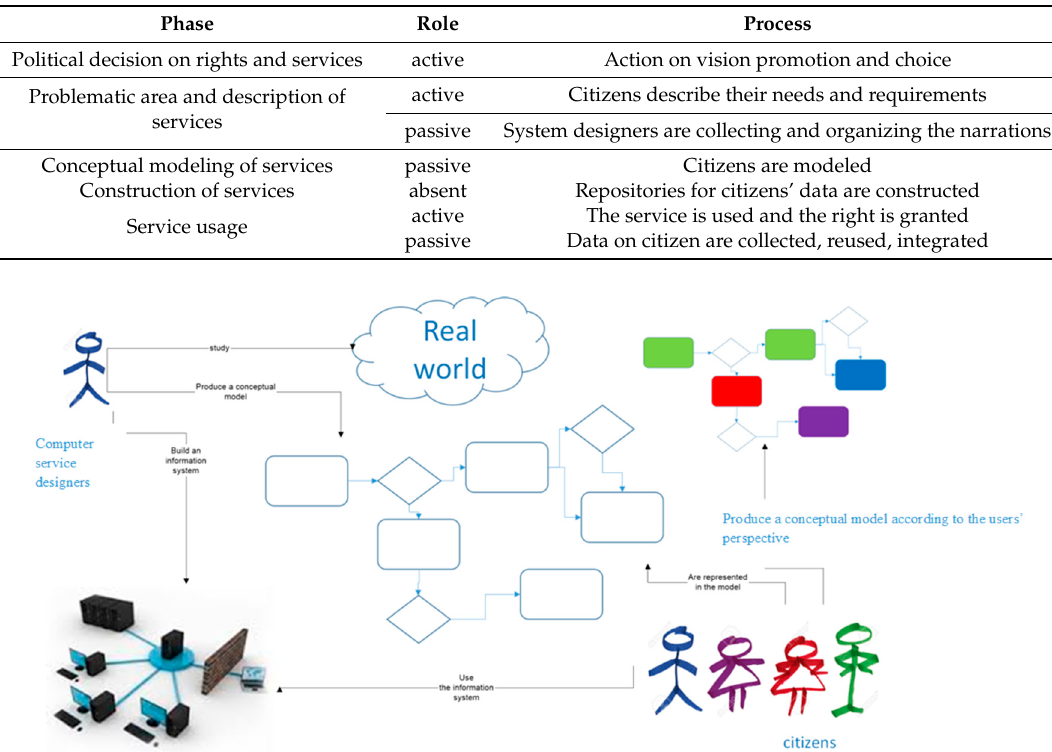
Figure 1. Natural language in the information system-developing scheme. With red borders are all of the phases affected by natural language. Table 1. Role of citizens.